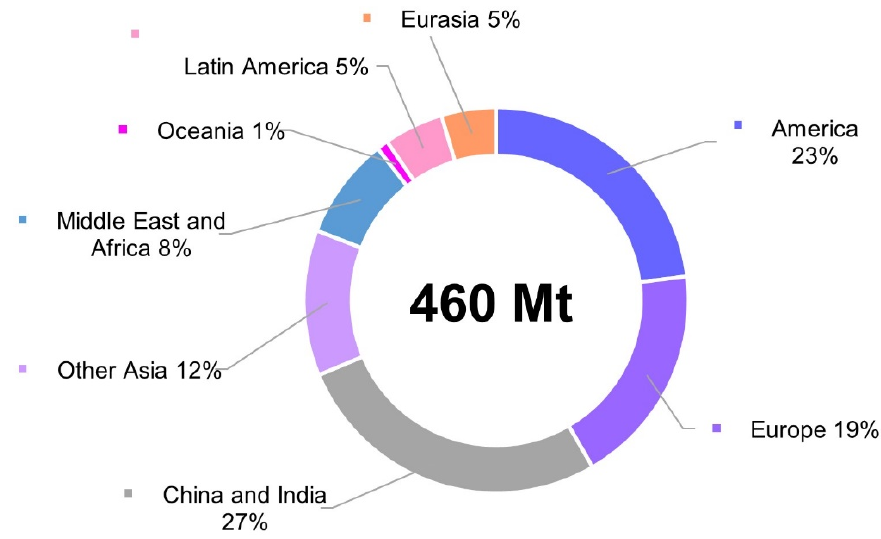
Figure 1. Global plastic use by region. The figure is created according to the data from OECD [1].